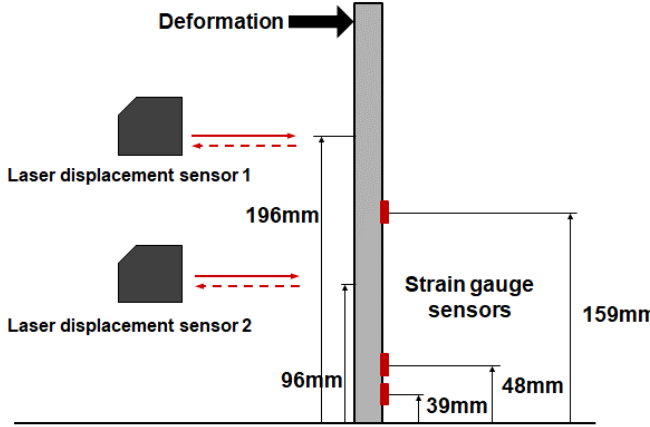
Figure 4. Test setup for strain-to-displacement transformation experiment.